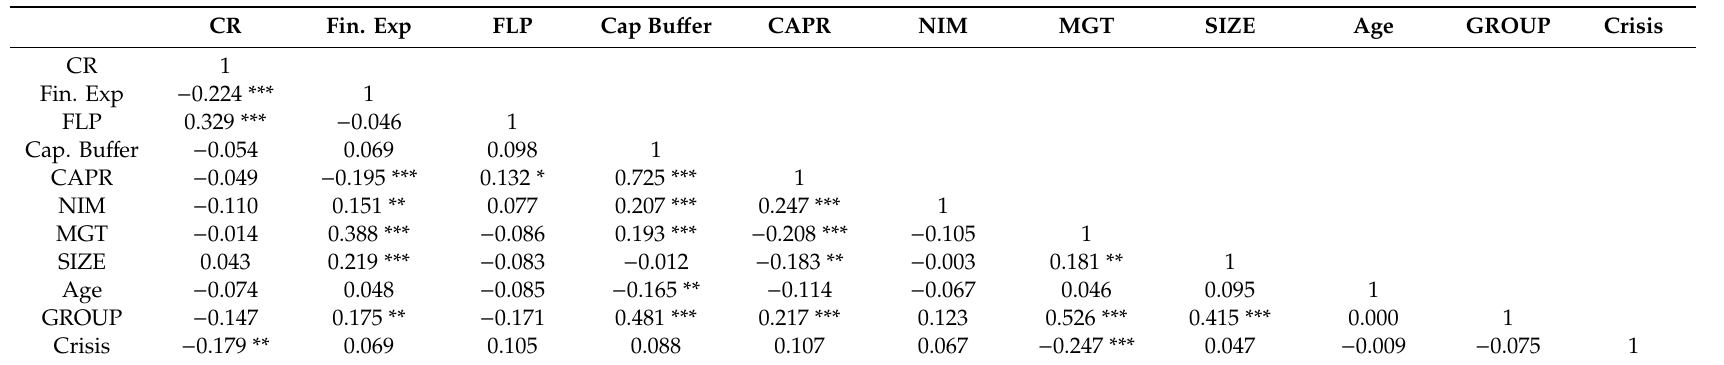
Table 4. Pairwise Correlation Matrix of Bank-specific